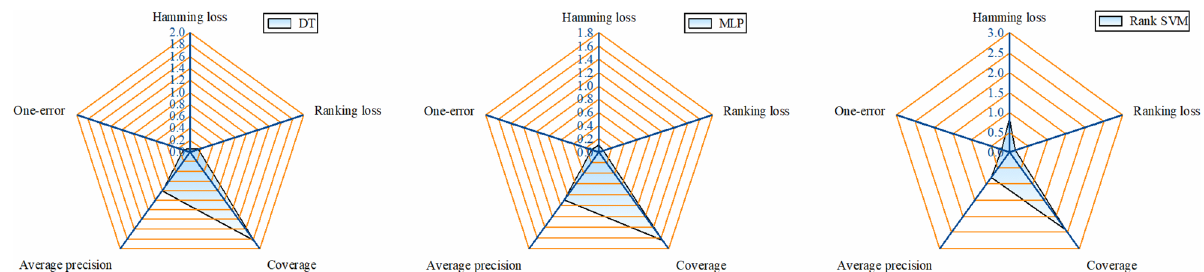
Figure 5. Cross-validation results for RVMFL diagnosis of the T-shaped angle-joint ventilation